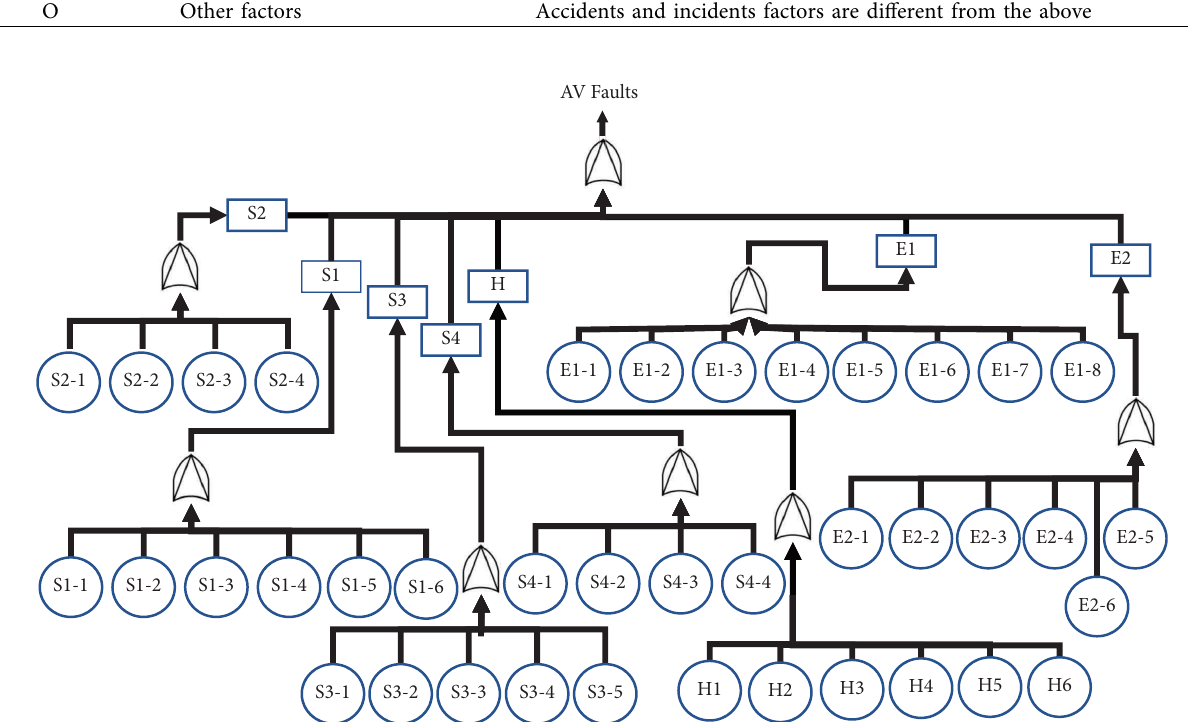
Figure 2: Classifcation diagram for ADS risk factors and accident